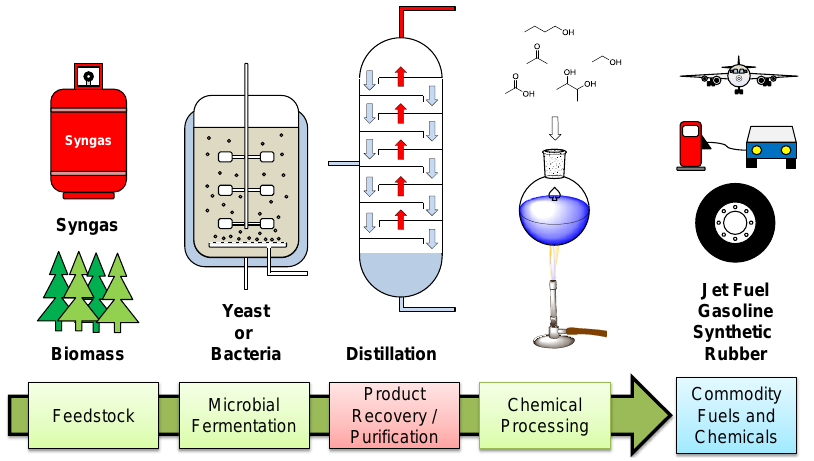
Figure 1. Processes involved in the microbial production of fuels and chemicals.